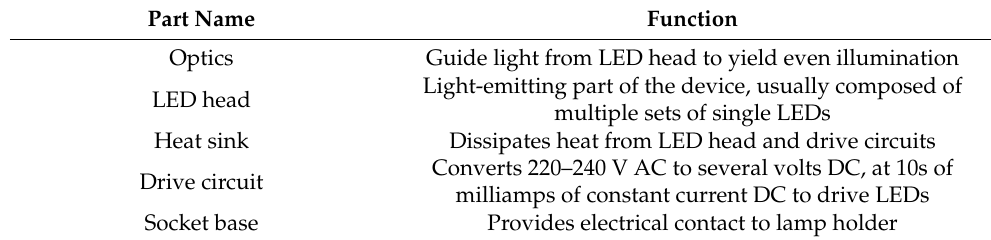
Table 2. Functions of each part of the LED spotlights.